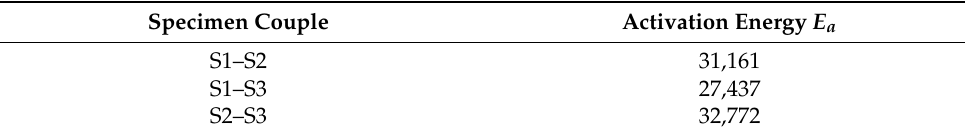
Table 3. E a for UHPC